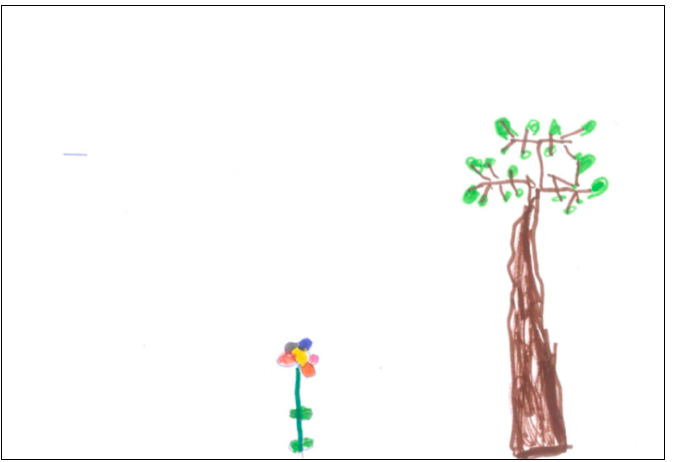
Figure A1. The drawings on the topic of plant that a 5 year old child completed in 2019.